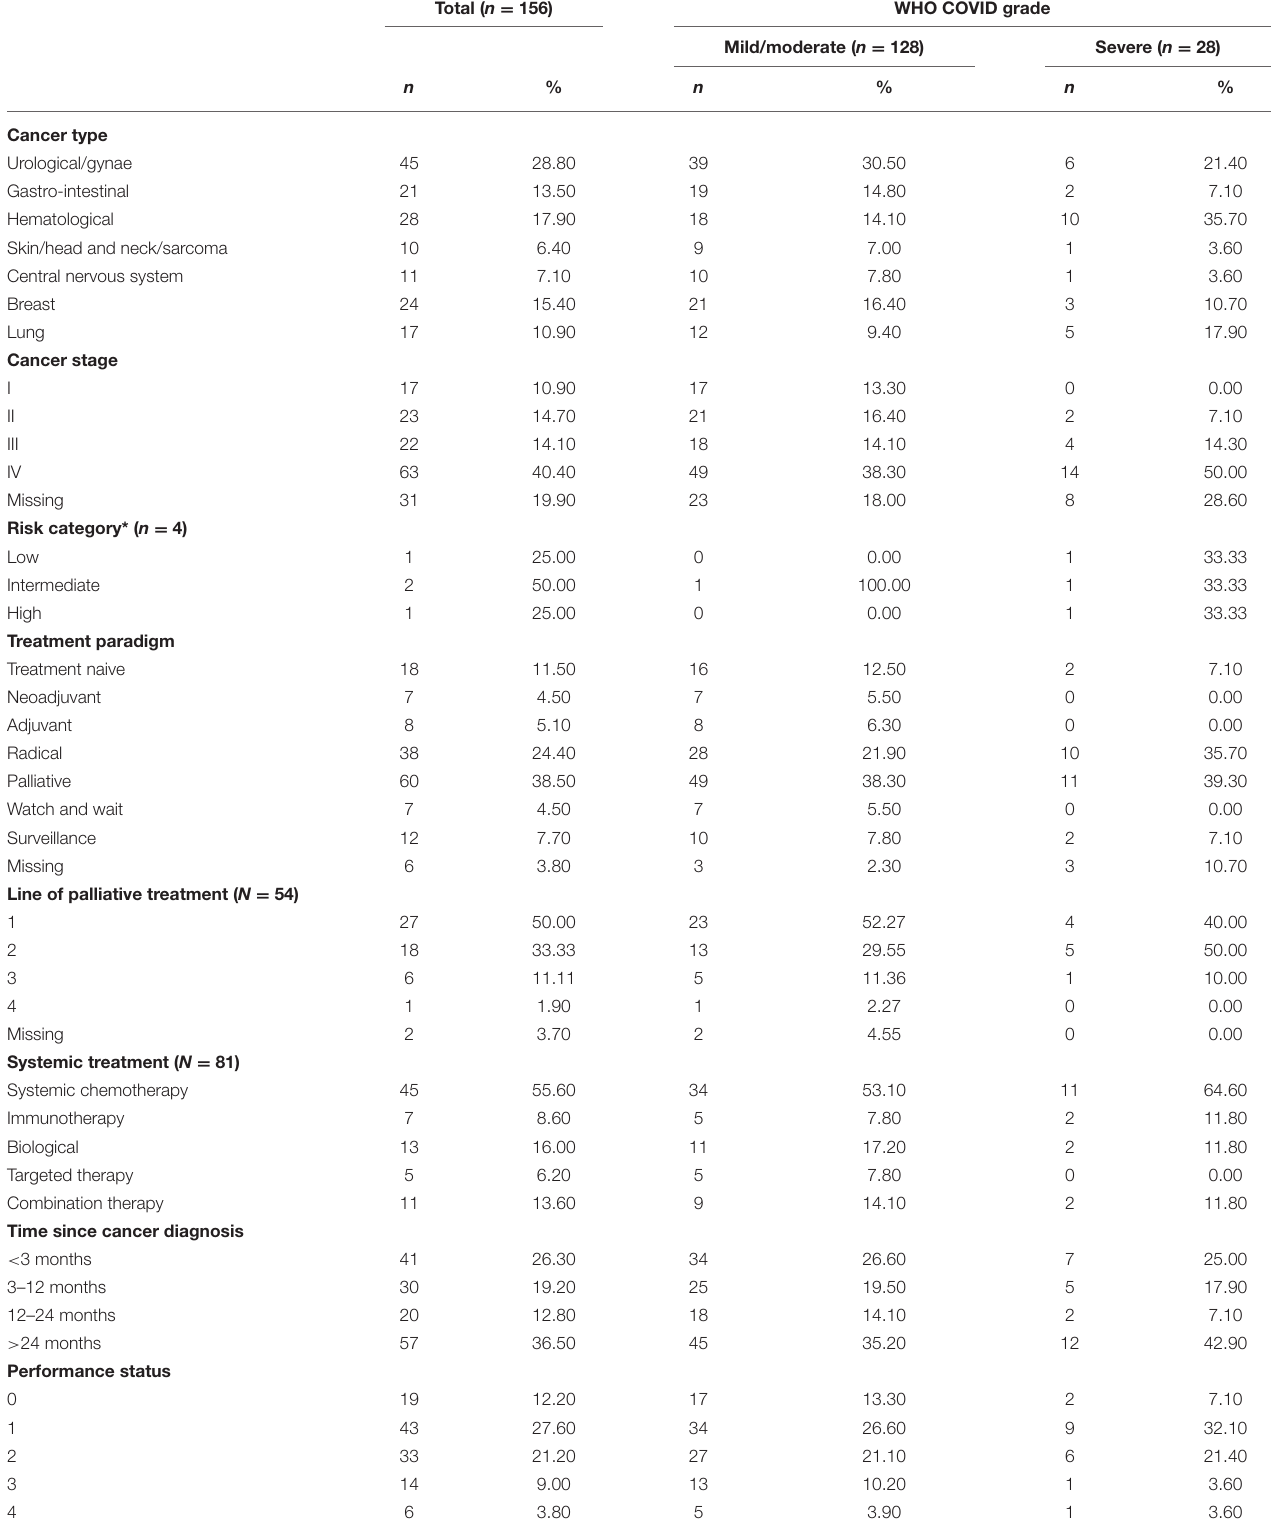
TABLE 2 | Tumor characteristics of COVID-19 positive cancer patients. Total ( n = 156) WHO COVID grade Mild/moderate ( n = 128) Severe ( n =